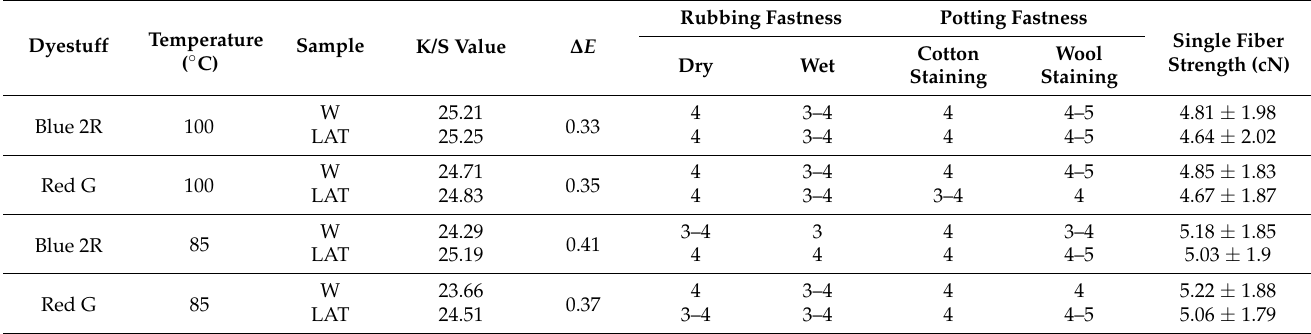
Table 1. Dyeing properties of W and LAT dyed at 100 °C and 85 °C for 60 min.